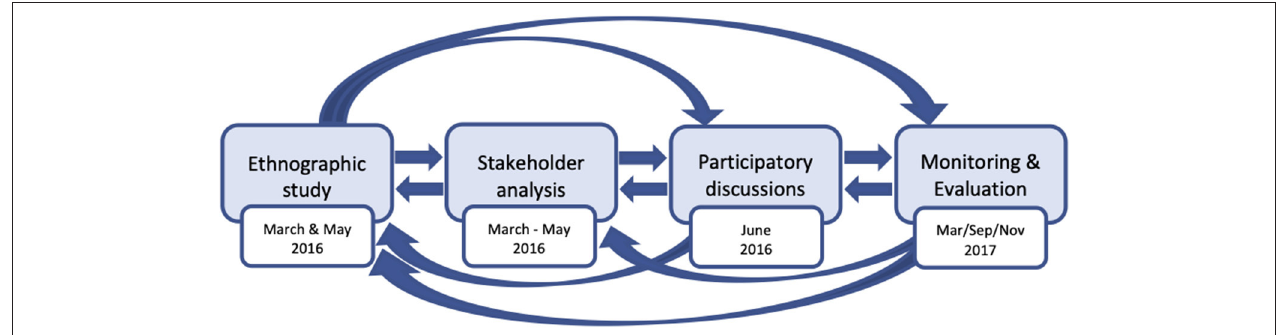
FIGURE 1 | Cyclical process of the community participatory